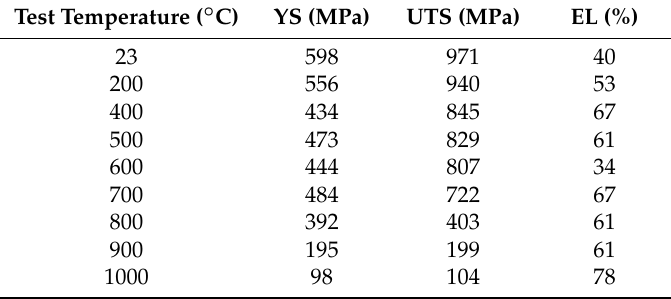
Table 2. Inconel 625 mechanical properties obtained by the tensile tests at room temperature to 1000 °C.